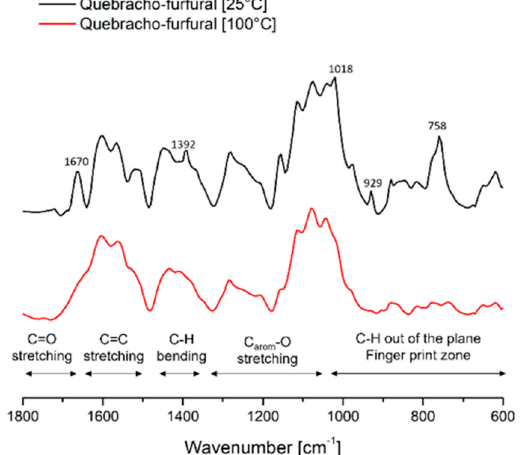
Figure 2. ATR-FTIR of Quebracho tannin furfural formulations at room temperature (black) and cured at 100 °C (red).